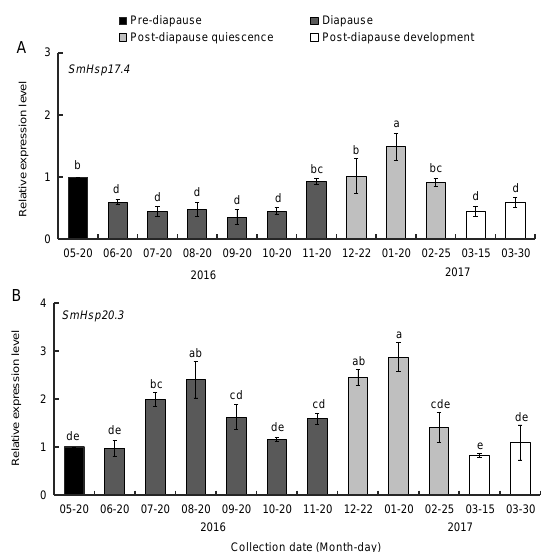
Figure 4. Expression profiles of SmHsp17.4 ( A ) and SmHsp20.3 ( B ) in pre-diapausing, diapausing, and post-diapausing larvae by RT-qPCR. The expression level of each tested stage was relative to that of the pre-diapause stage, which was arbitrarily set at 1. Bars represent the means ± SE. Different letters above bars indicated significant difference by Duncan’s multiple range test ( p < 0.05).